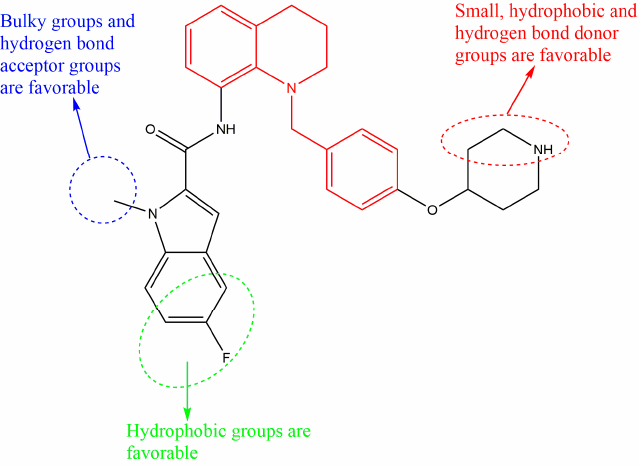
Figure 5. Structure-activity relationships (SAR). The pIC 50 values of these seven derivatives were predicted using the CoMFA and CoMSIA model, and the results are listed in Table 4. The values of pIC 50 predicted with CoMFA and CoMSIA ranged from 6.41 to 6.94 and 7.19 to 8.39, respectively. Obviously, value than the template molecule 18x . The docking scores, carried out with Schrödinger, report higher scores than 18x , which is consistent with the both the predicted pIC 50 and the